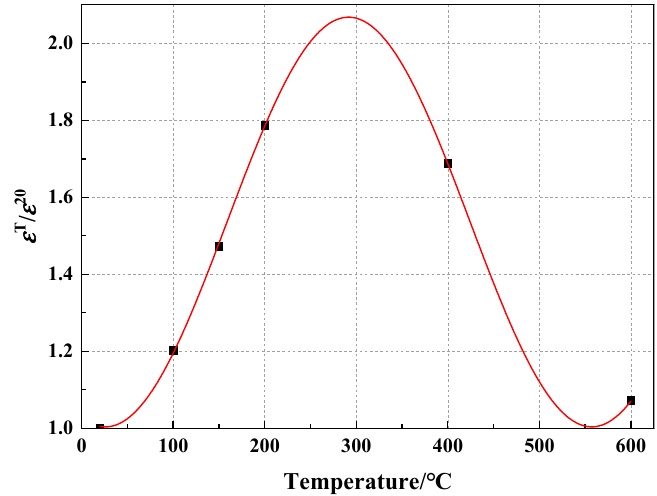
Figure 10. Peak strain ratio changes with temperatures.